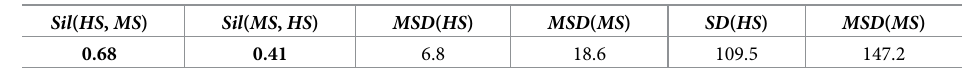
The subjects have been divided into two groups: HS and MS patients. The silhouette scores, MSD and SD have been computed on those groups.